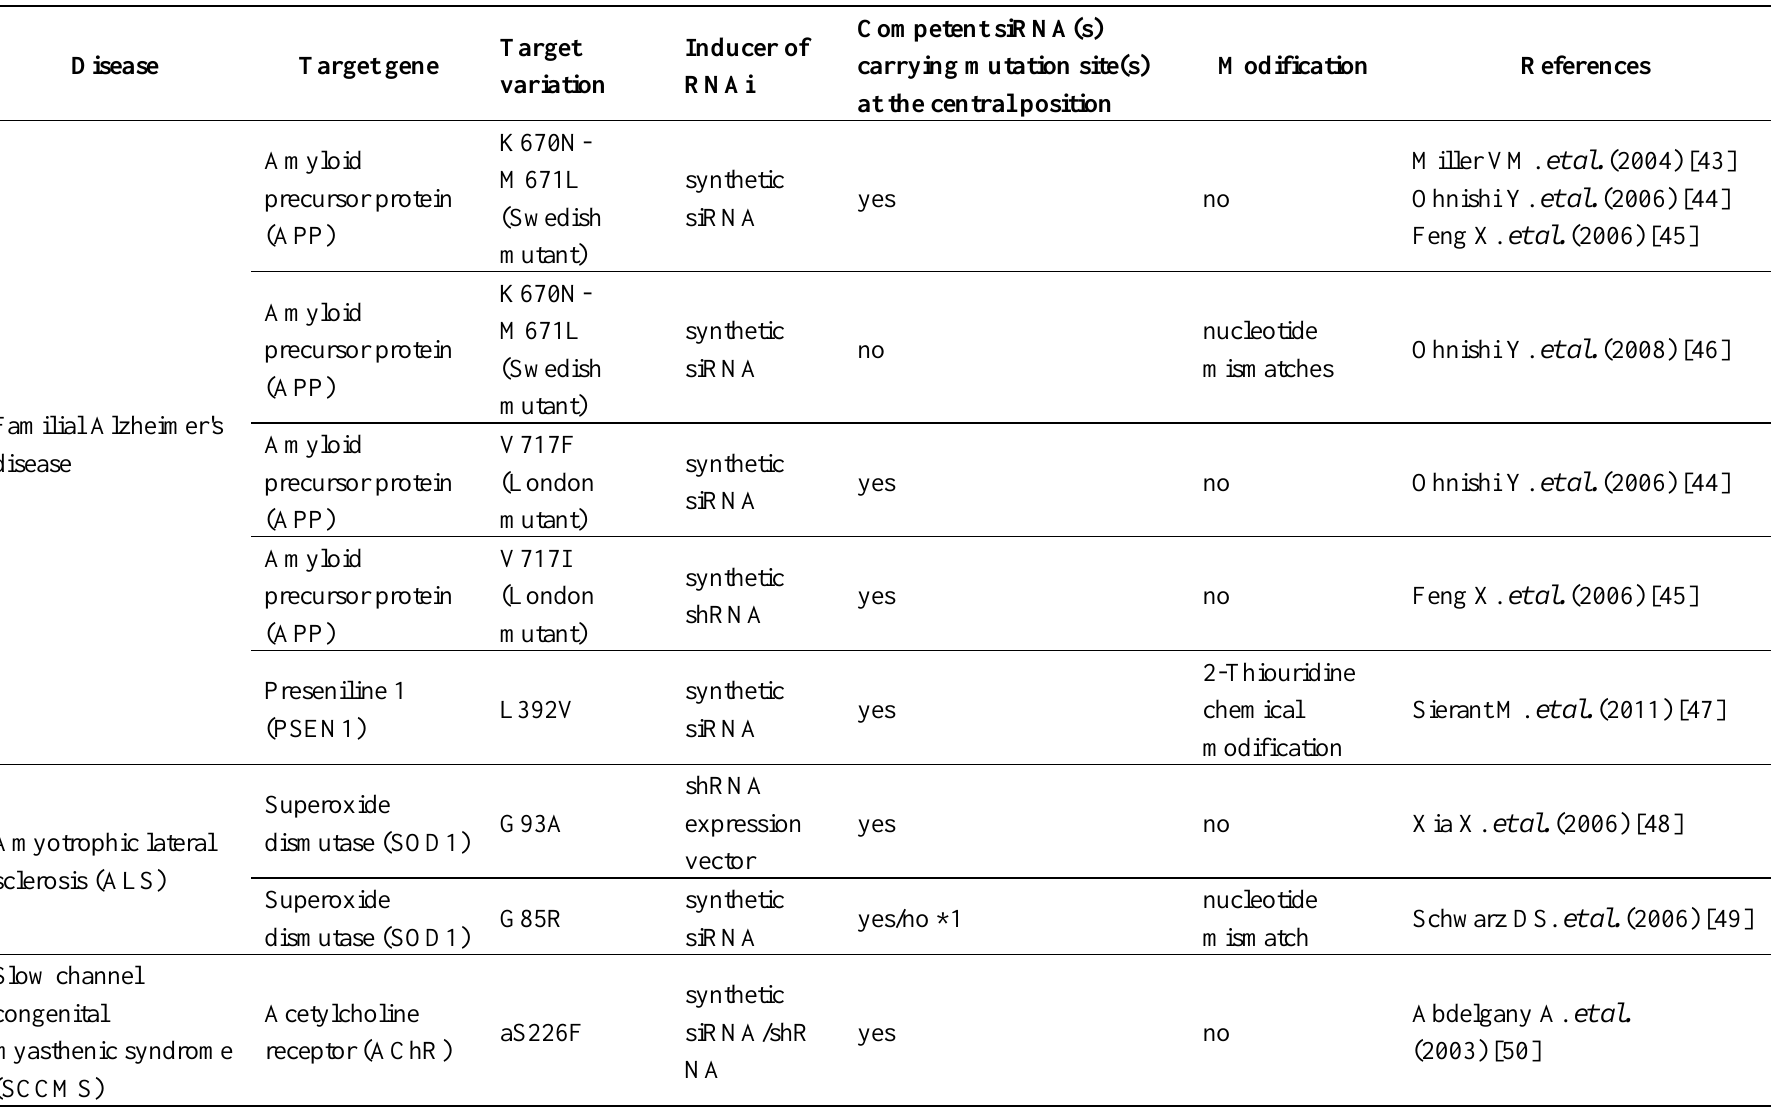
Table 1. Disease-causing allele-specific silencing by